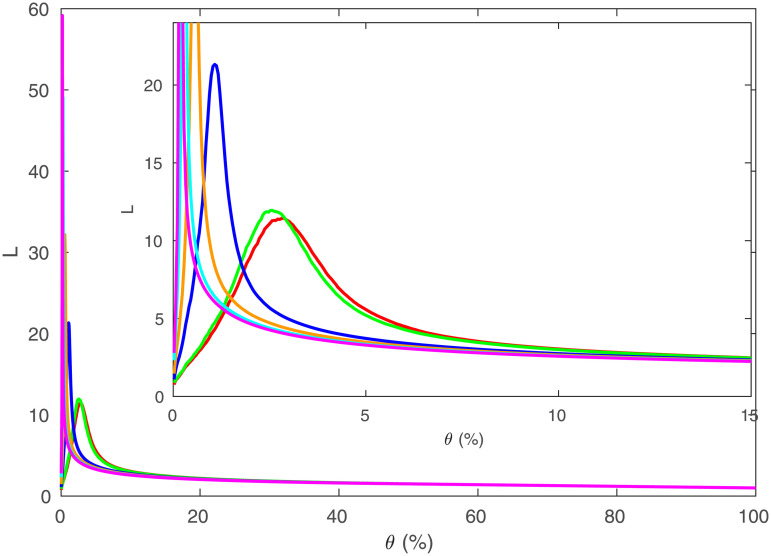
Path length vs. threshold.L vs. θ as in Fig 11a, but extended to cover all θ. The inset shows a closeup for low θ and L.